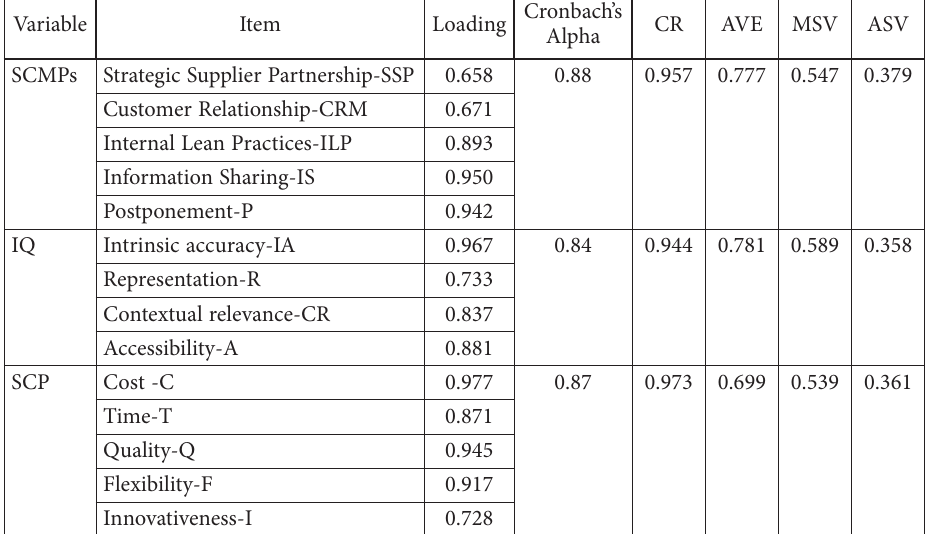
Table 1. Validity and reliability indices of the proposed